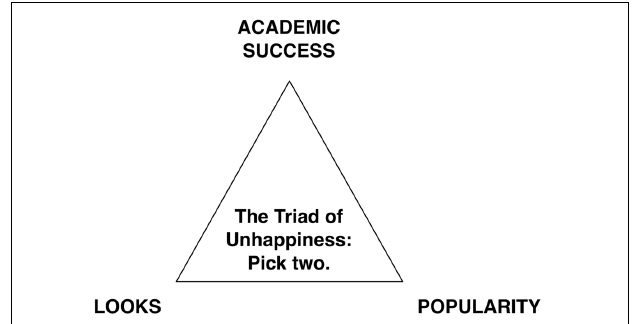
FIGURE 1 | The Triad of Unhappiness. The figure represents an application of the well-known Triple Constraint Model from project management (originally comprising scope, time, and cost) to